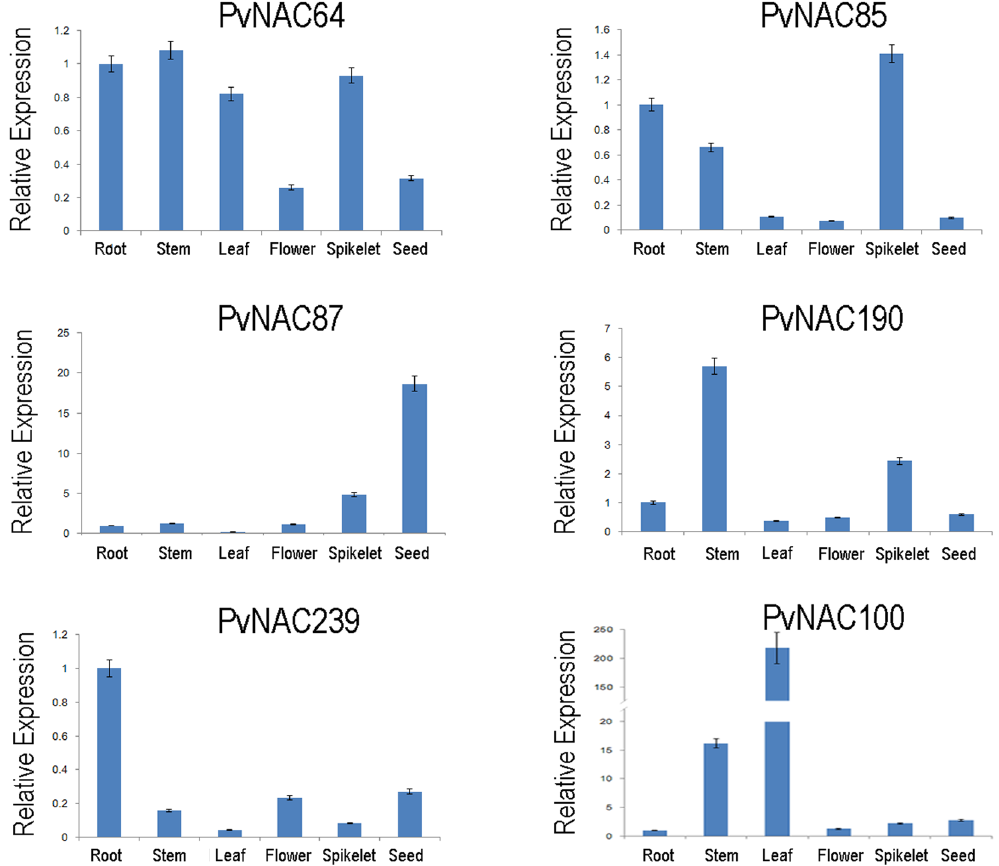
Figure 7. The expression analysis of selected six tissue specific PvNAC s via qRT-PCR. Relative expression of these PvNAC s were normalized in relation to reference gene UCE2 in different tissues (Root, stem, leaf, flower, spikelet, seed). The bars represent error